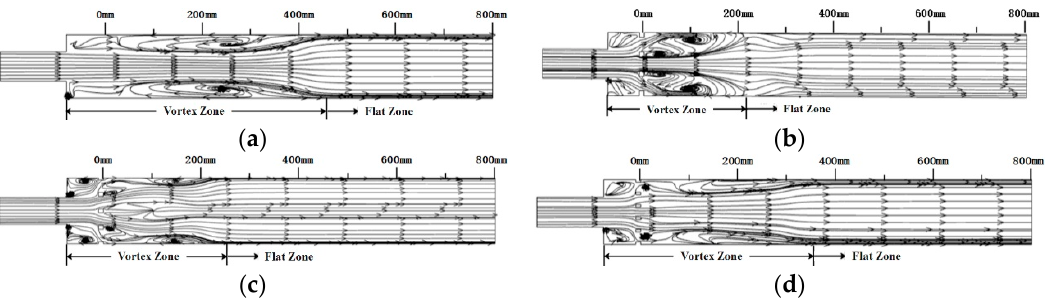
Figure 13. Streamlines of entrance heads with four types of SPBs in longitudinal section, ( a ) without SPB, ( b ) 3 × 3 SPB, ( c ) 4 × 4 SPB, and ( d ) 5 × 5 SPB.